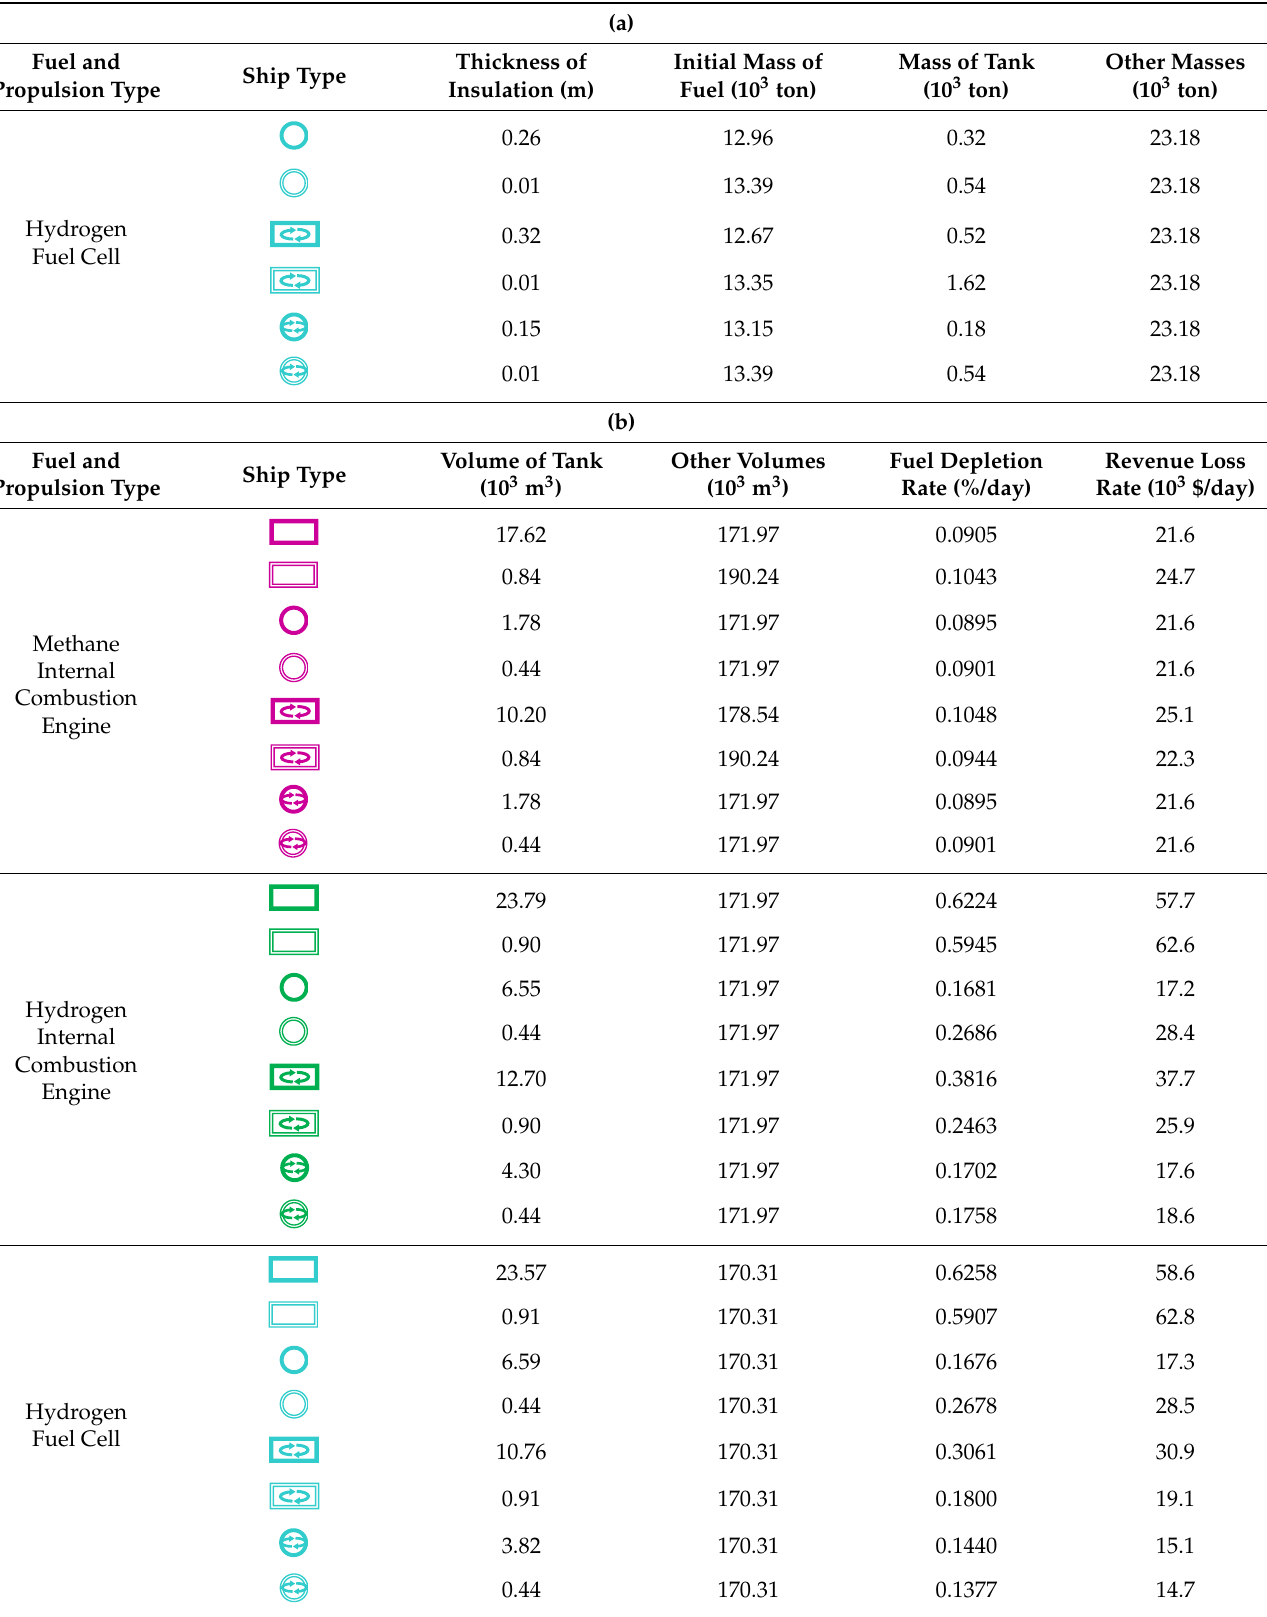
Figure A3. Variation of remaining fuel mass and energy with voyage duration at BN = 2 and a re- sultant velocity of 16.7 knots. All investigated LH2 fuel cell ships are shown at the insulation thick- ness that maximises the fuel delivered after a voyage of 20 days. References 1. Raj, R.; Ghandehariun, S.; Kumar, A.; Geng, J.; Linwei, M. A techno-economic study of shipping LNG to the Asia-Pacific from Western Canada by LNG carrier. J. Nat. Gas Sci. Eng. 2016 , 34 , 979 – 992. https://doi.org/10.1016/j.jngse.2016.07.024. 2. The Hydrogen Council Hydrogen Decarbonization Pathways. Available online: https://hydrogencouncil.com/wp-content/up- loads/2021/01/Hydrogen-Council-Report_Decarbonization-Pathways_Executive-Summary.pdf (accessed on 7 March 2022).